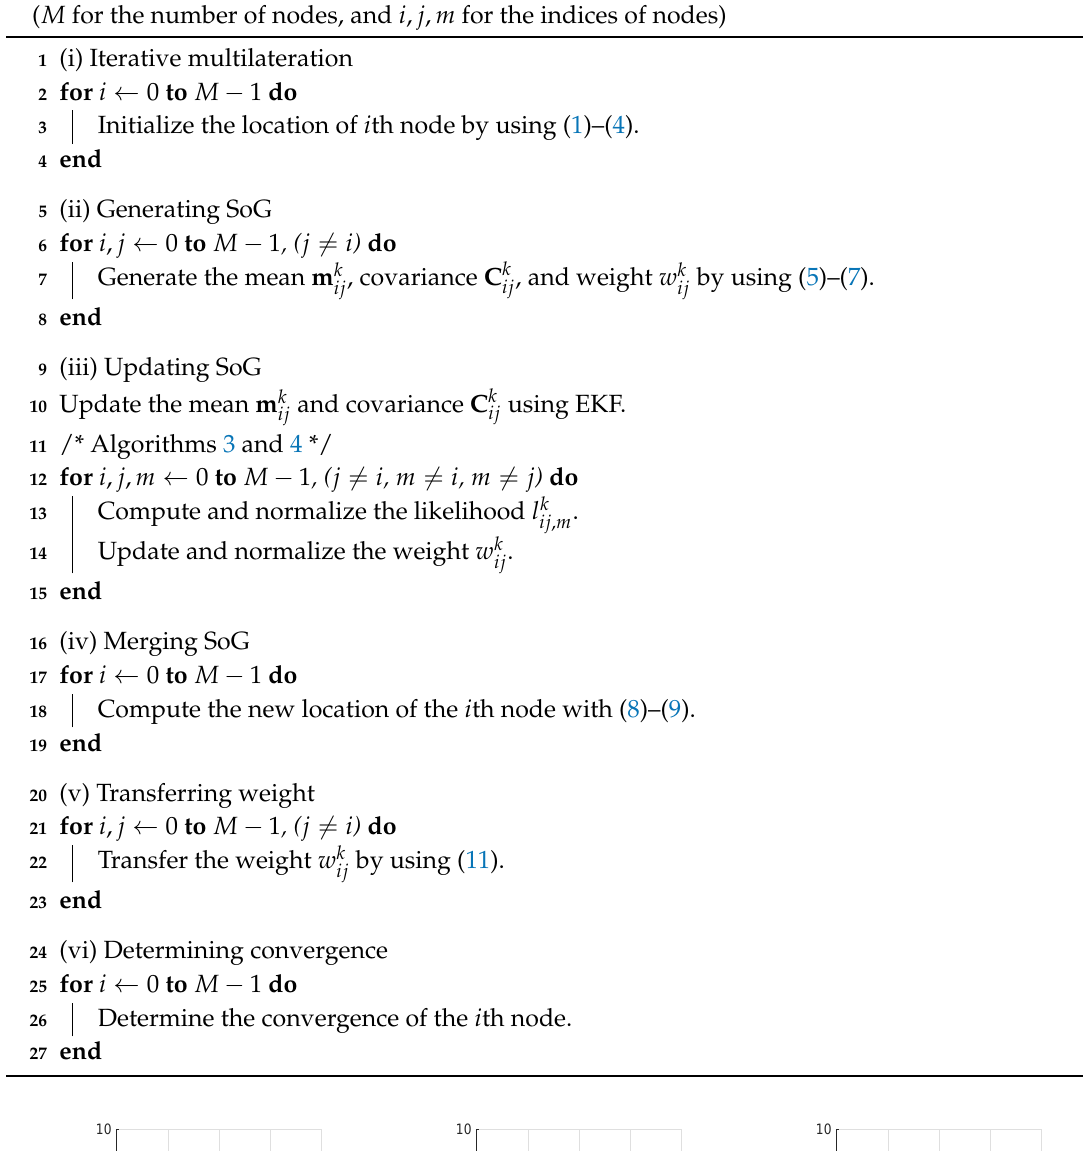
Algorithm 1: Initialization stage of the CDRO-SLAM.